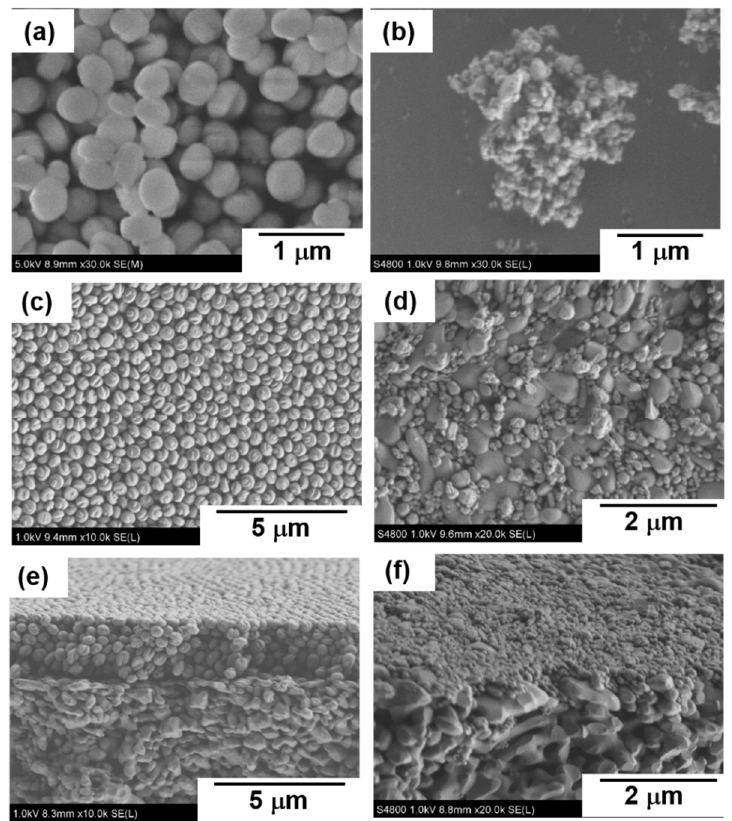
Figure 3. Typical FE-SEM images of seed crystals and seeded supports. ( a , b ) seed crystals for S-1 S and S-1 M ; ( c , d ) the surface of seeded supports for S-1 S and S-1 M . ( e , f ) the cross-section of seeded supports for S-1 S and S-1 M